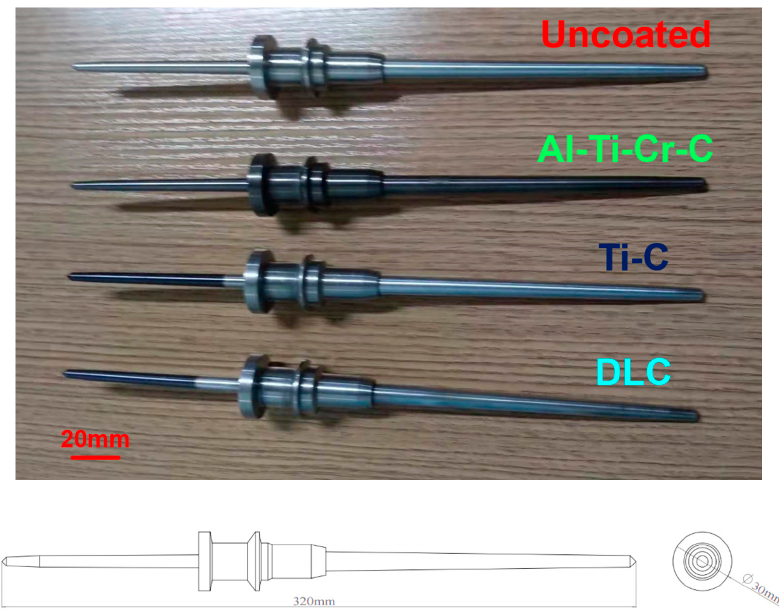
Figure 2. Experimental spindle and its 2D technical drawing.